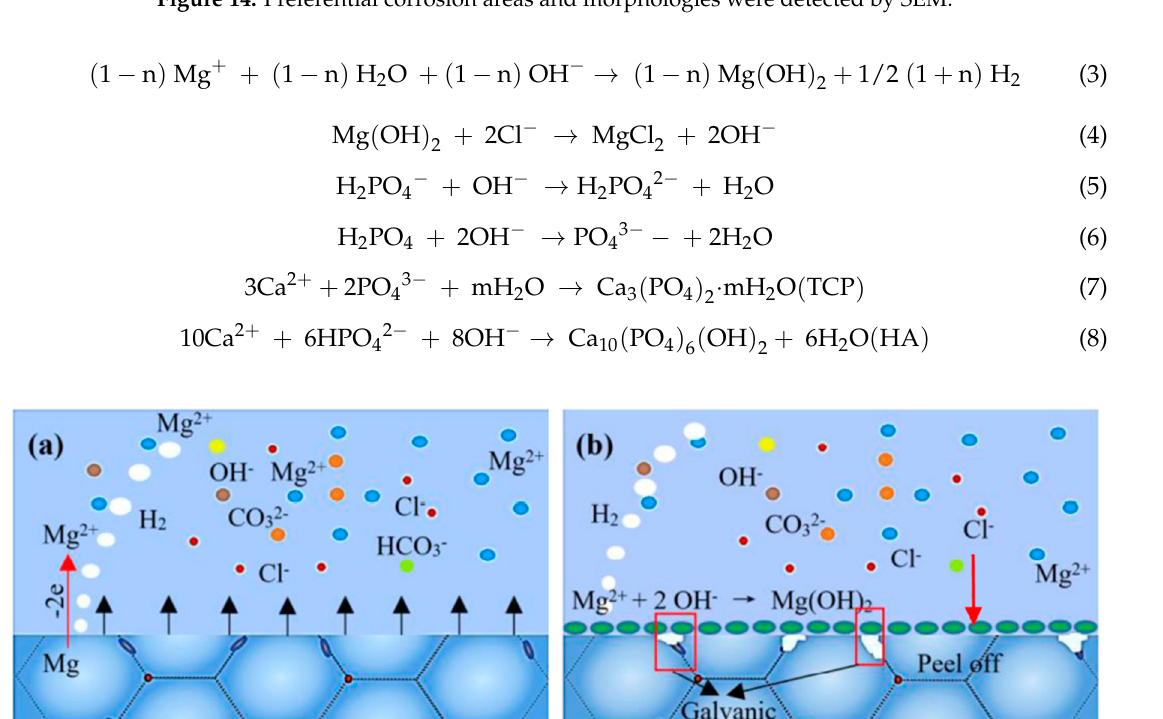
Figure 14. Preferential corrosion areas and morphologies were detected by SEM.